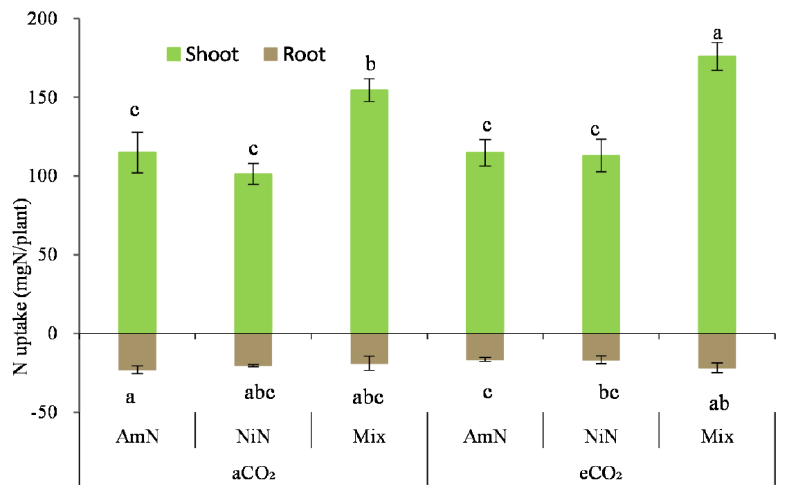
Figure 8. The N uptake of maize seedlings. Note: (1) AmN denotes Ammonium N, NiN denotes Nitrate N, Mix denotes Mixed N; (2) TC means total C concentration, TN means total N concentration; (3) aCO 2 denotes the ambient atmospheric CO 2 concentration at 390 µ mol/mol; eCO 2 denotes the enriched atmospheric CO 2 concentration at 690 µmol/mol; (4) Different letters mean significant differences at p < 0.05 level for each indice; (5) error bars are standard deviation; (6) above− and belowground LSD are separate analyses. Table 10. Two − factor ANOVA analyses for C and N concentrations in maize seedlings. Shoot C Maize Concentration